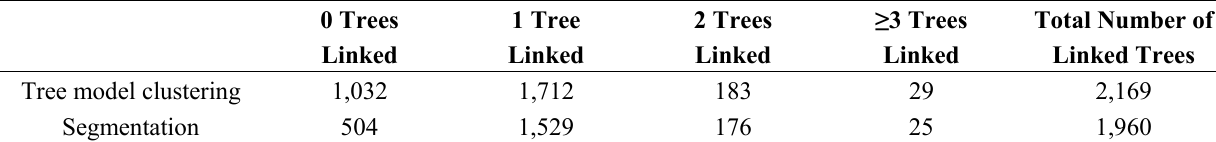
Table 5. The number of clusters and segments linked to 0 field-measured trees, 1 field-measured tree, 2 field-measured trees, and ≥ 3 field-measured trees.